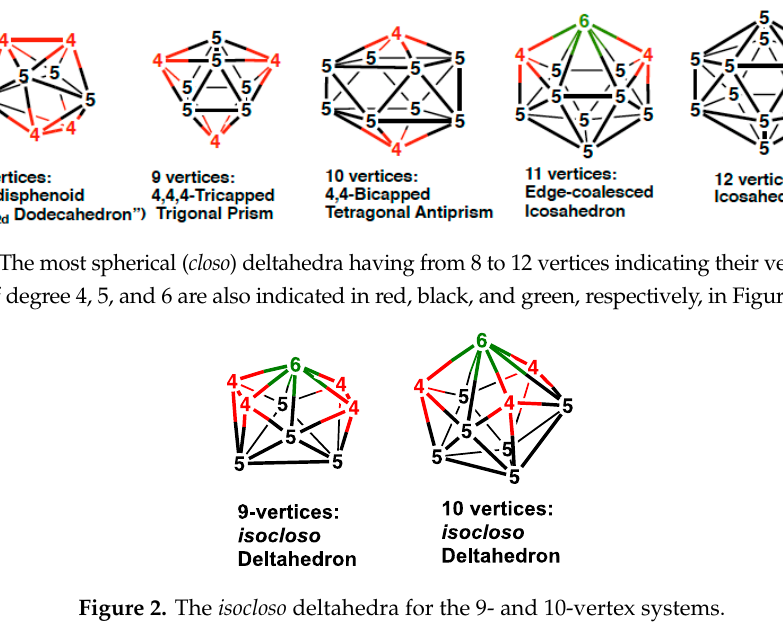
Figure 1. The most spherical ( closo ) deltahedra having from 8 to 12 vertices indicating their vertex degrees. Vertices of degree 4, 5, and 6 are also indicated in red, black, and green, respectively, in Figures 1 and 2.